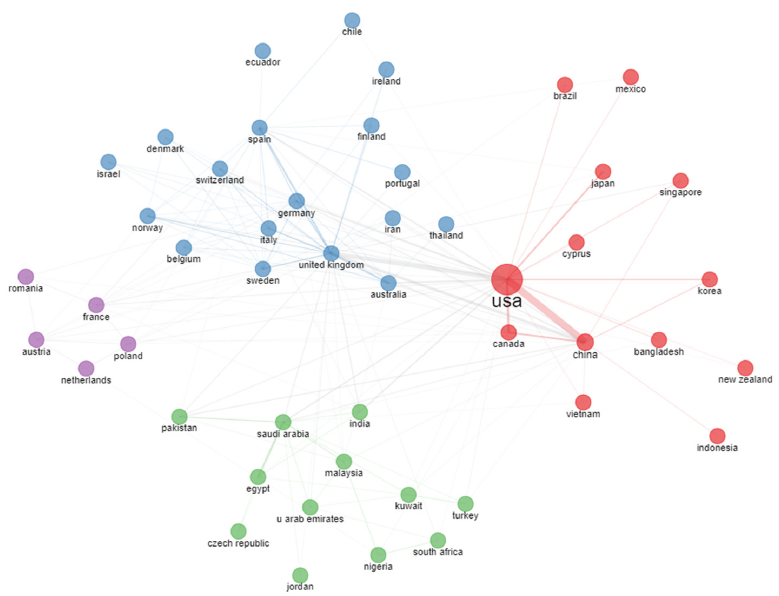
Figure 7. Map of collaboration among countries (this map was generated by Biblioshiny).